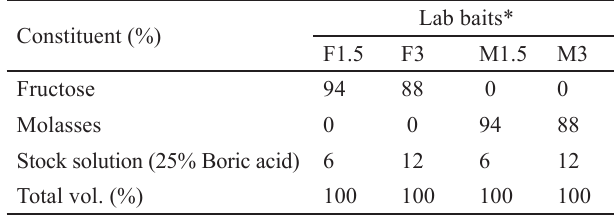
Table 1 . Ratio of each constituent used in new laboratory bait prepa -